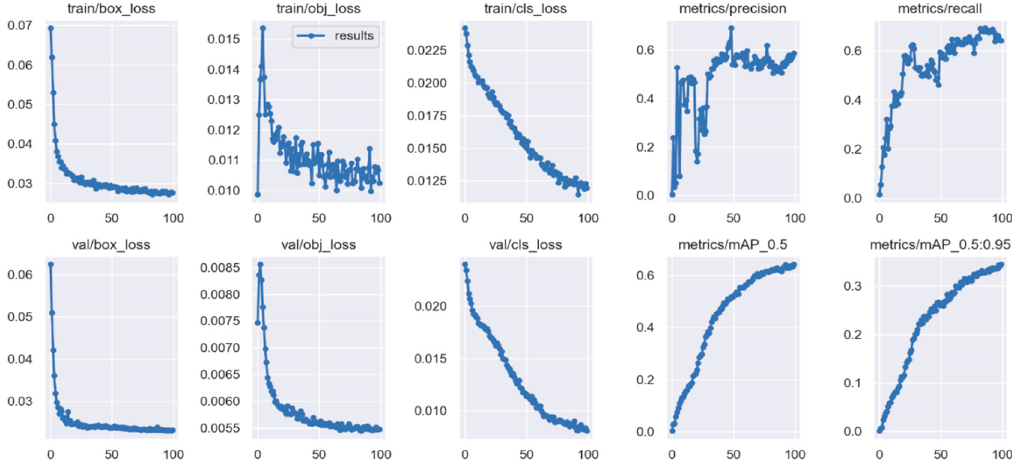
Figure 9. YOLOv5 results of training (upper row) and validation (lower row) .